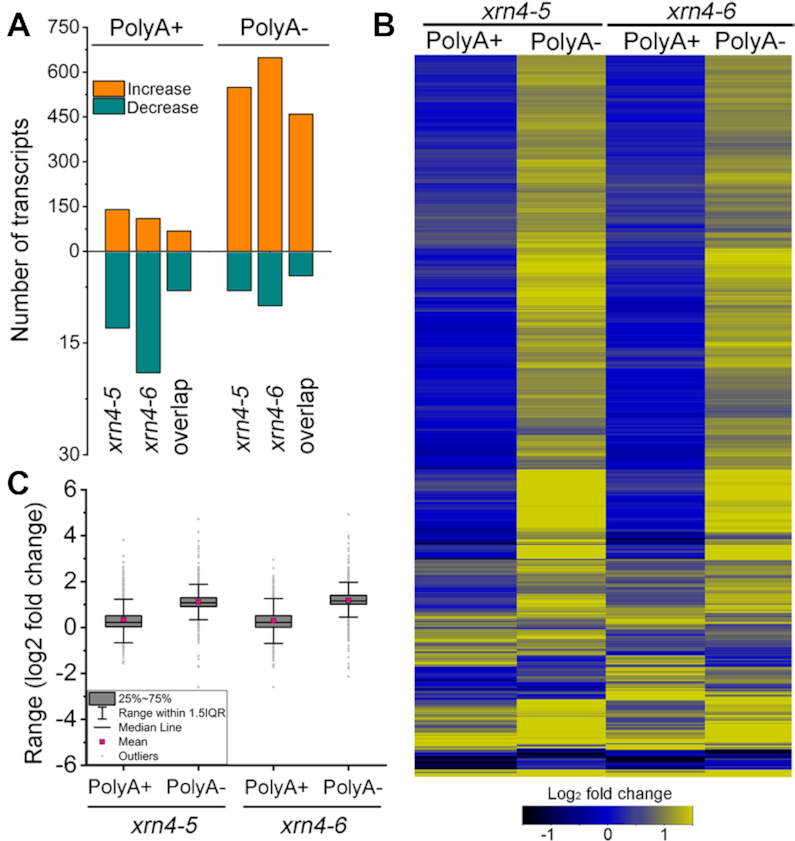
Elevation of many nonpolyadenylated transcripts in xrn4 seedlings. (A) Histograms show the number of protein-coding transcripts that are either increased or decreased (≥2 fold i.e. log2≥ ±1); FDR-adjusted P< 0.05) in two xrn4 mutants relative to the WT (Col-0) in polyA+ and polyA- RNA-seq. Overlap, number of differentially accumulating transcripts that are in common between the mutants. (B) The heat map illustrates the fold changes in the xrn4 mutants of differentially accumulating transcripts (Supplementary Dataset S1). (C) Box plots show the range of fold changes in xrn4 mutants for differentially accumulating transcripts described in panel (B).